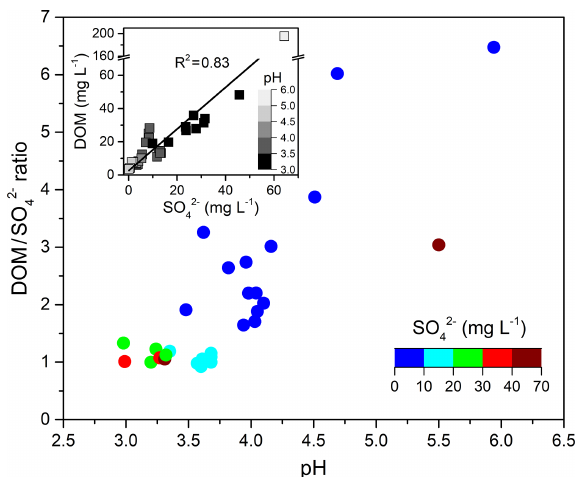
Figure 9. Mass concentration distributions of major water-soluble components in the pre-cloud and post-cloud aerosols for cloud events E.1 and . 4